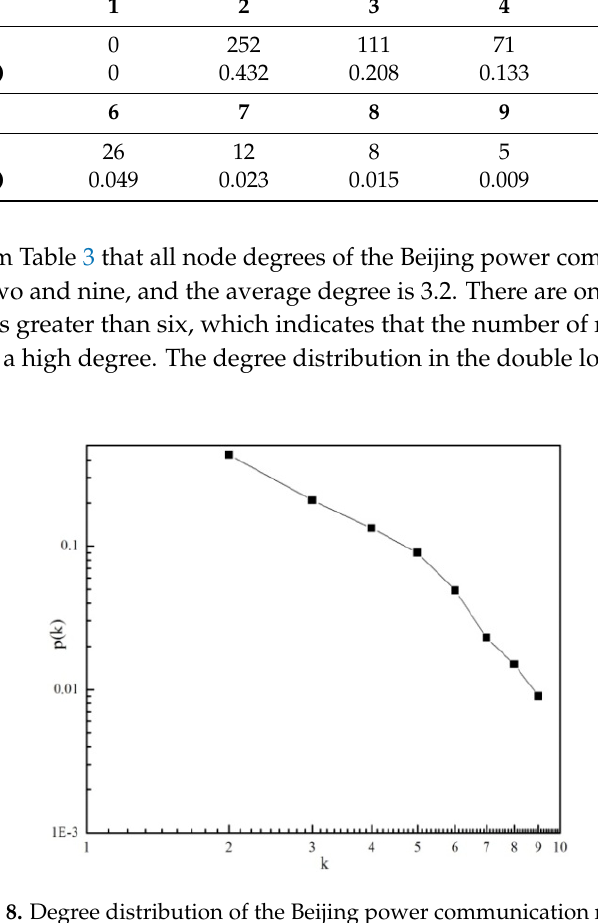
Figure 9. Local topology of the Beijing power communication network.